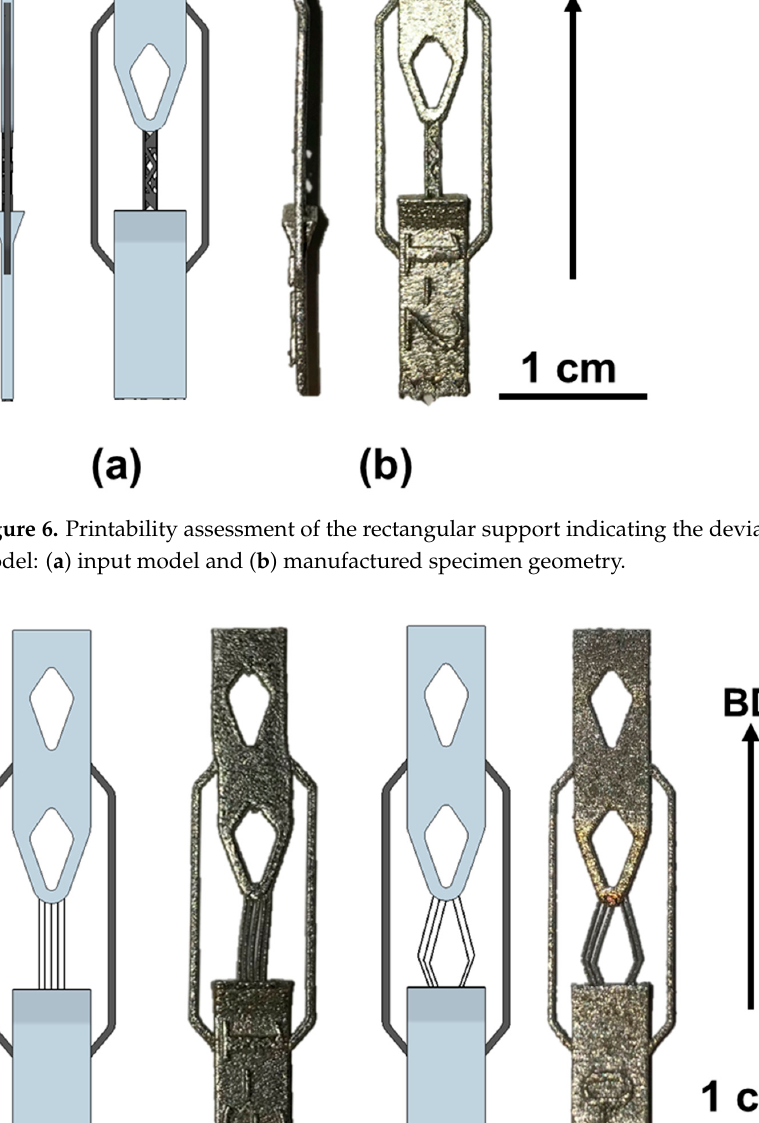
Figure 7. Printability assessment of the line support: ( a ) input CAD model of the initial design; ( b ) bending of the support caused by using a single line; ( c ) modified CAD model incorporating two connected lines with an included angle; ( d ) successful manufacturing of the specimen geometry with the modified design .